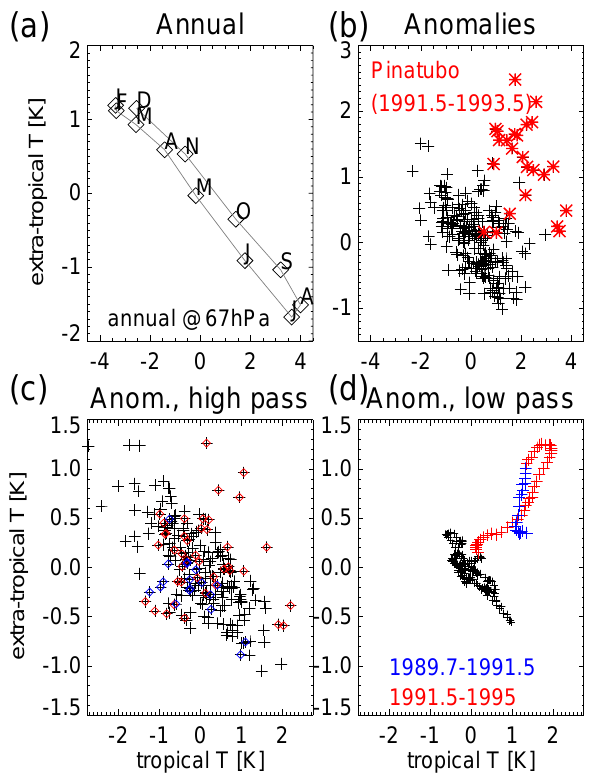
Fig. 7. Temperature correlations tropics-extratropics based on ERA-Interim data at 67hPa. (a) Climatological mean annual cycle (data from 1995–2009). (b) Interannual anomalies after subtrac- tion of mean annual cycle. Red asterisks show data of period of anomalous stratospheric aerosol loading following the eruption of Pinatubo. (c) High-pass filtered version of interannual variability (24-month running mean subtracted from original timeseries). Data points prior to and following Pinatubo eruption are shown in blue and red, respectively. (d) The low-pass filtered data, note that 24- month averaging kernel leads to loss of 24 months of data, and to smearing out of the Pinatubo-related